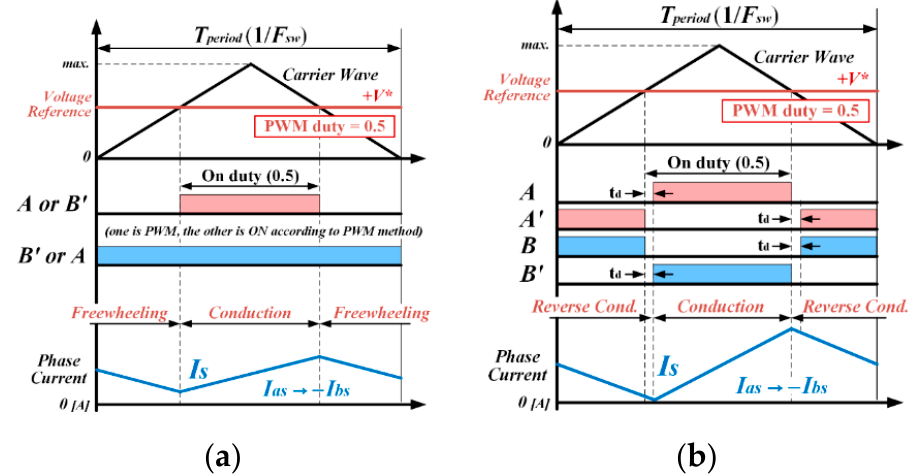
Figure 2. Example of PWM patterns in one switching cycle of Position Sector 1: ( a ) unipolar type PWM method; ( b ) bipolar type PWM method. V* is the value of reference voltage for the PWM control. This value is output from the current controller and used for PWM